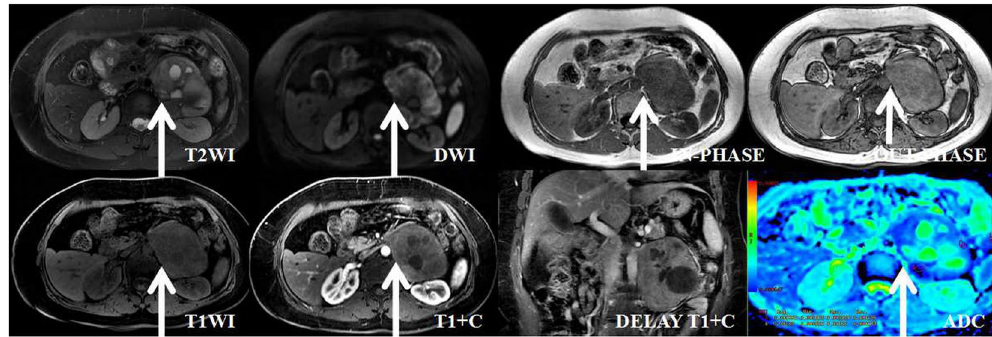
Figure 4. A 53-year-old woman with dizziness and hypertension and a histologically proven benign retroperitoneal paraganglioma at the left paravertebral region (adjacent to the left adrenal gland). The transverse and longitudinal diameters of the tumor are 8.04 cm and 9.71 cm, respectively. ( A ) In axial T2WI, the tumor exhibits mixed signal intensity, including high signal intensity, slightly high signal intensity, and isointensity, compared with the gluteal muscles. The signs of fluid-fluid levels can be seen. The intratumoral septa exhibit low signal intensity. ( B ) In axial DWI, the tumor appears with a ring of high signal intensity. ( C – E ) In T1WI (in-phase, out-phase and pre-scanned imaging, respectively), the signal of the tumor is slightly lower than that of the gluteal muscle in in-phase imaging and pre-scanned imaging, and exhibits a linear and sheet-like high signal in out-phase imaging. ( F ) In contrast T1WI during the arterial phase, the tumor exhibits slight and non- homogeneous enhancement. The center exhibits no enhancement of the necrotic area. ( G ) In coronal T1WI during the delay phase, the tumor is slightly enhanced. ( H ) ADC imaging; the mean ADC value of the ROI of the tumor is 0.00130 mm 2